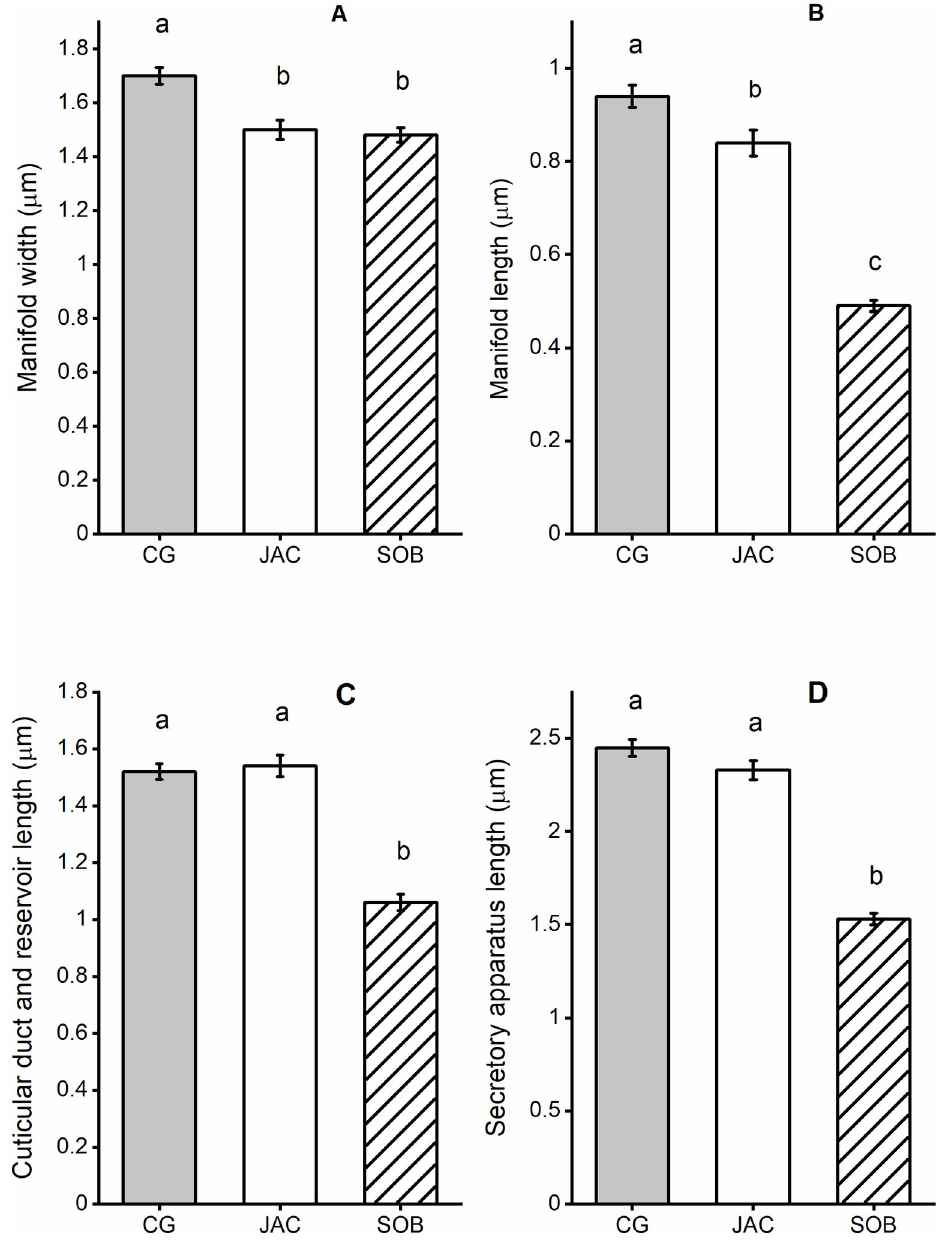
Fig 4. Dimensions of the components of the secretory apparatus observed in 3 members of the Lu . longipalpis s.l. species complex. Mean size of the measured structures ( μ m); manifold width (A), manifold length (B), reservoir and cuticular duct length (C) and secretory apparatus length (D) for each of the three members of the Lutzomyia longipalpis species complex; Campo Grande (CG), Jacobina (JAC) and Sobral (SOB). Error bars are ± standard error of the mean. Tukey’s test was used to compare sizes of structures between each member of the complex, measurements with the same letter (a, b or c) were not significantly different (P < 0.05) from each other.